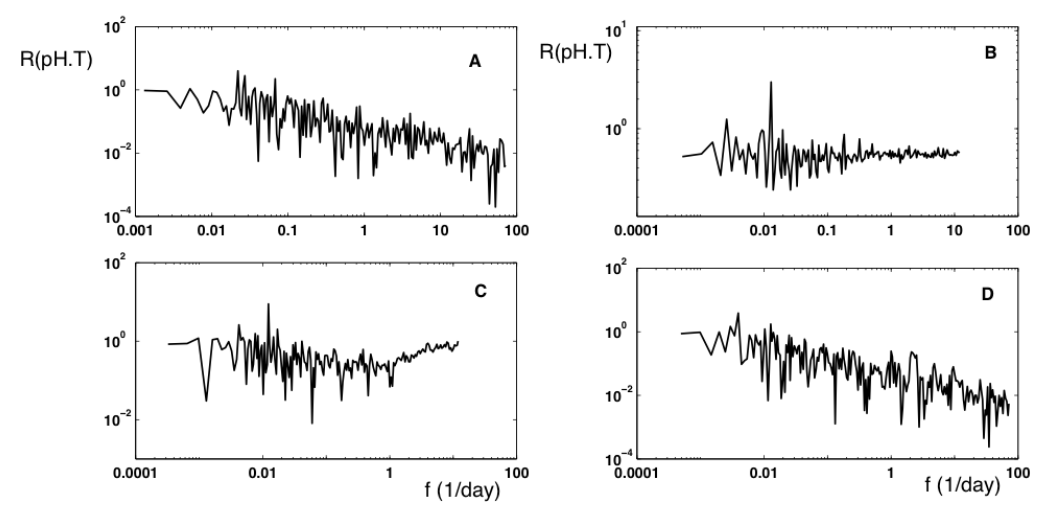
Fig. 9. Coherency spectra R pH ,T estimated between pH and temperature for each series. (A) Carnot; (B) Grande rade; (C) La Carosse and (D) Honfleur. Flat zones indicate frequency ranges for which the pH fluctuations have spectral properties proportional to temperature’s.